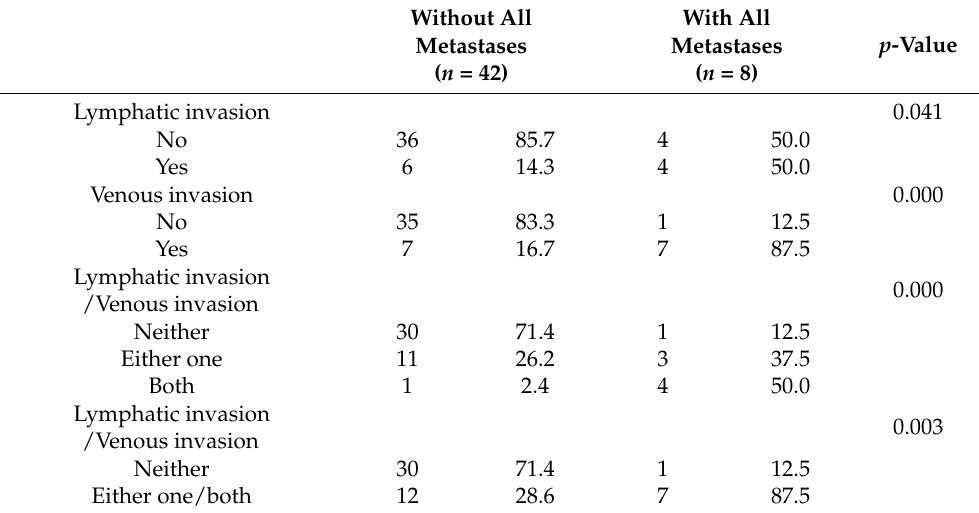
Table 5. Comparison of cases with and without all